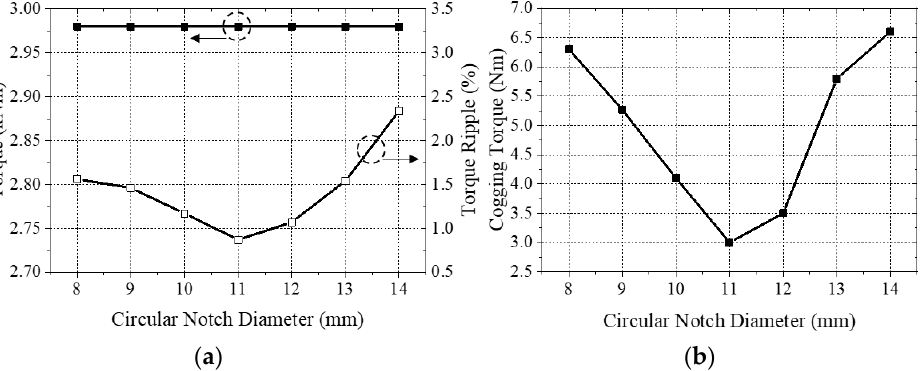
Figure 12. ( a ) Maximum torque and torque ripple performance and ( b ) cogging torque with respect to the diameter of the circular notch used on the rotor.